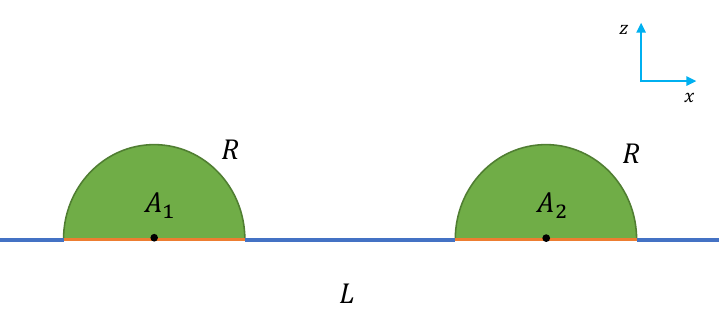
Figure 2 . Two distant spheres in the conformal vacuum. The two spheres A 1 and A 2 with radii R 1 = R 1 = R are separated by a large distance L (cid:29) R